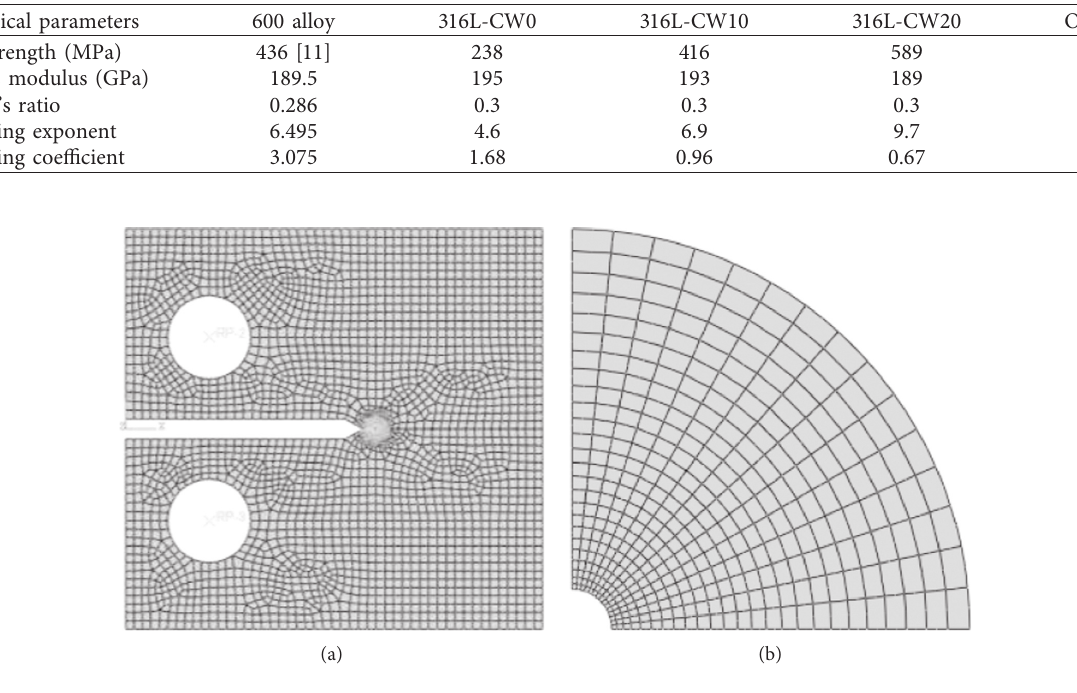
Figure 2: Finite element